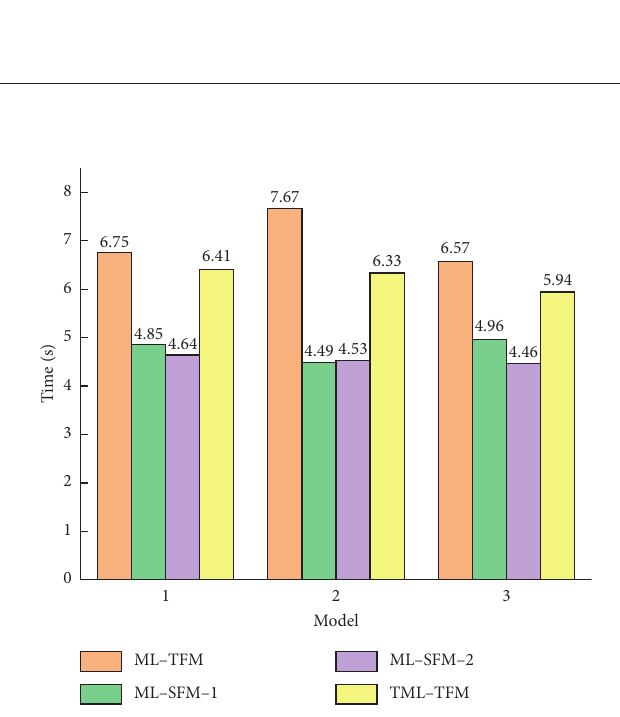
Figure 11: Imaging time of different